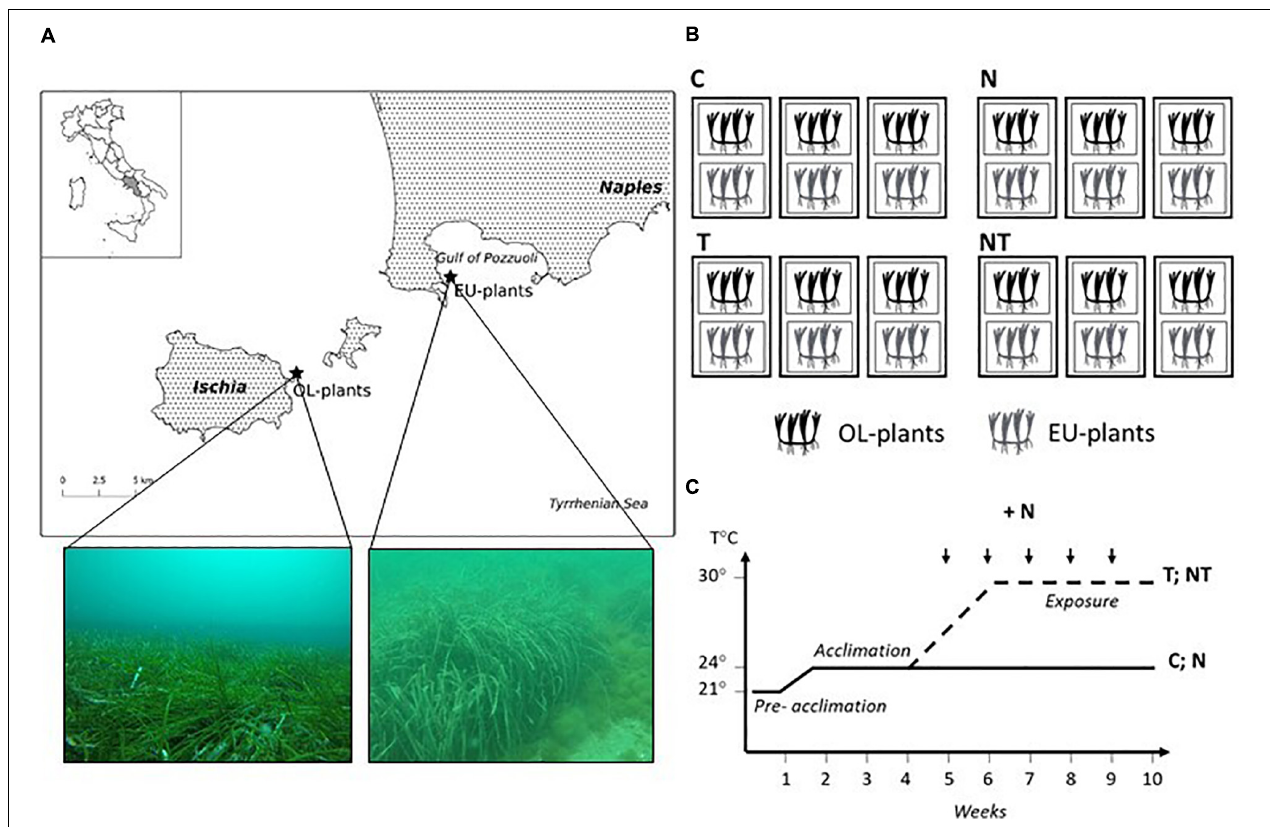
FIGURE 1 | (A) Sampling area for OL (oligotrophic) and EU (eutrophic) plants in the Tyrrhenian Sea. (B) Experimental layout of the SZN mesocosms system included three tanks per treatment (C = Control, T = Temperature, N = Nutrients, NT = Nutrients plus Temperature). In each tank, one basket for each EU and OL plants was placed, each basket containing two plant fragments. (C) Experimental timeline showing main events: exposure to high temperature (T; NT) and nutrient additions (N; NT) (see text for more details). Arrows indicate periodical nutrient additions to keep nutrients levels within the selected experimental